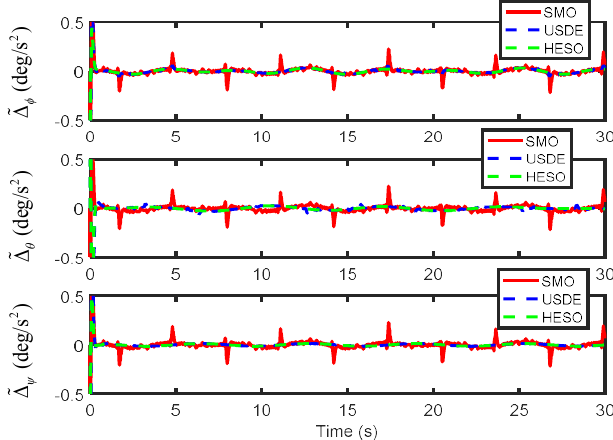
Figure 6. Estimation errors of USDE, SMO and HESO. Table 3. Quantitative analysis of USDE, SMO and HESO.